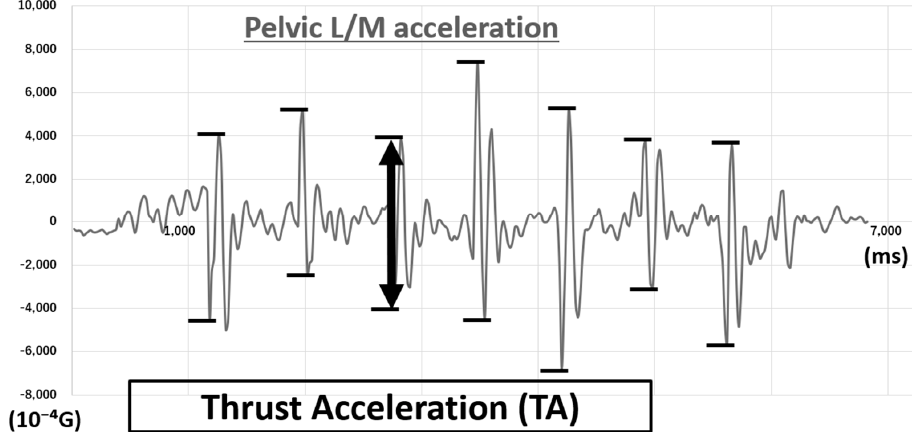
Figure 3. The peak-to-peak difference of acceleration in the lateral/medial (L/M) axis using a pelvic inertial measurement unit (IMU) from a representative case. (G = 9.81 m/s 2